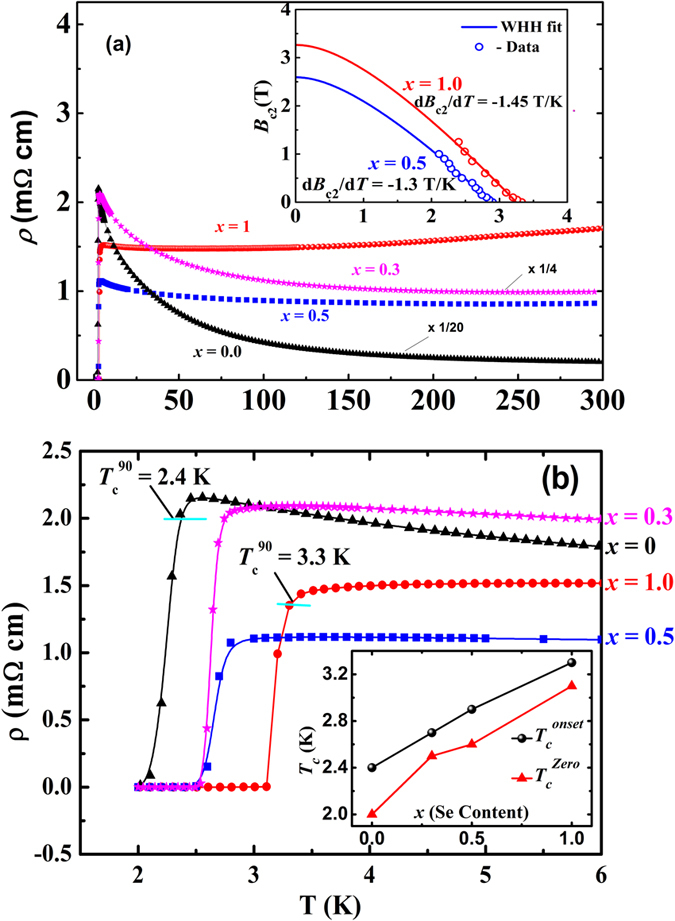
Variable temperature resistivity curves for Sr0.5Ce0.5FBiS2-xSex; x = 0, 0.3, 0.5 and 1.0. The data for x = 0 and 0.3 have been divided by 20 and 4 respectively (a) in temperature range 2–300 K and (b) in low temperature range. Inset of (a) shows the upper critical field (Bc2) versus temperature (T) curve for the x = 0.5 and 1.0 compositions (open circles) along with the WHH fit (solid lines). Inset of (b) shows the variation of Tconset and Tc (ρ = zero) as a function of Se-doping.